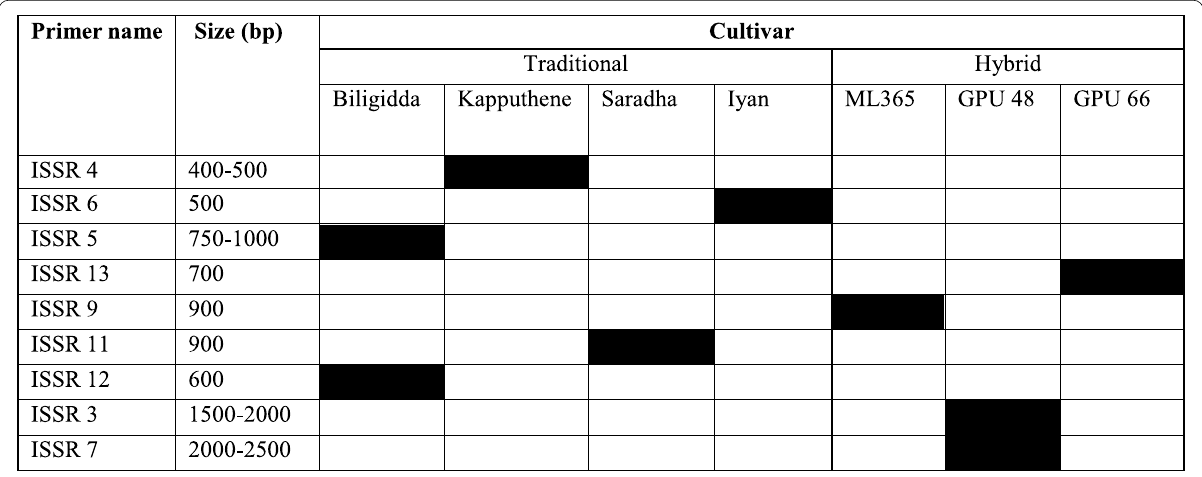
Fig. 2 ISSR primers and their marker-specific DNA marker for identification of certain important traditional and hybrid varieties of finger millet in